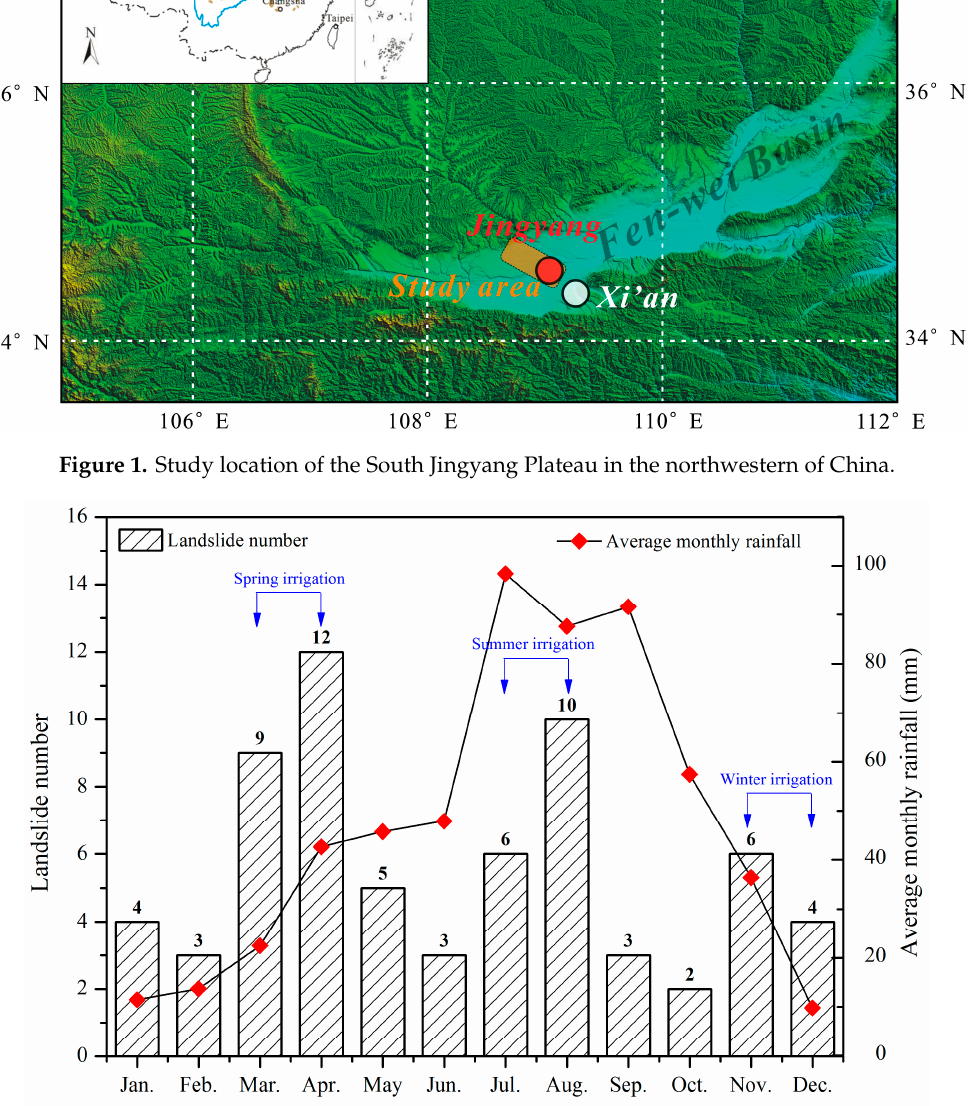
Figure 1. Study location of the South Jingyang Plateau in the northwestern of China.